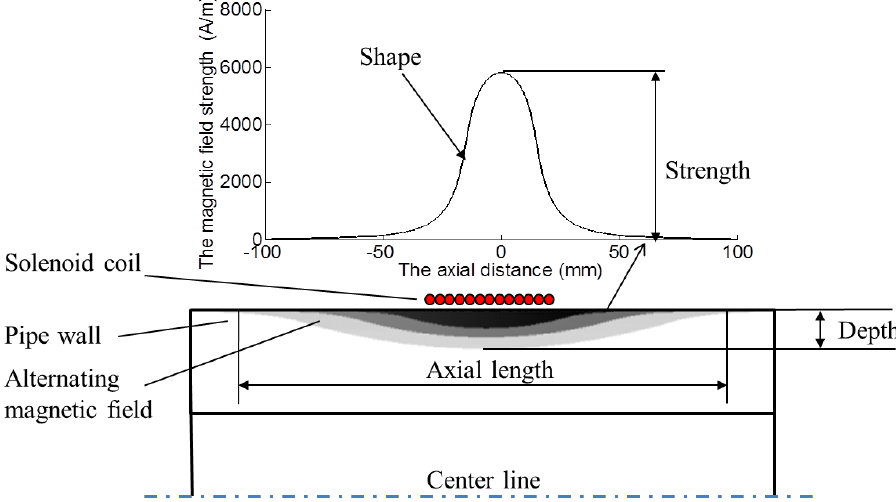
Figure 3. The parameters of the alternating magnetic field produced by a solenoid